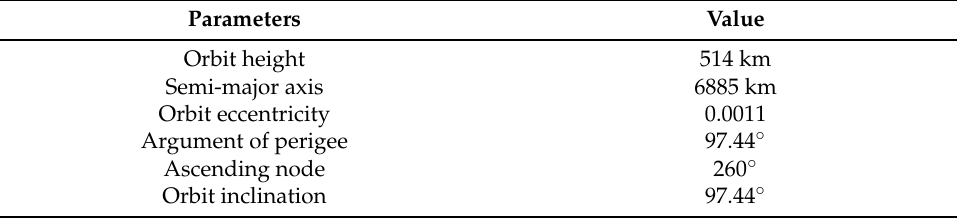
Table 1. Satelite orbit parameters.